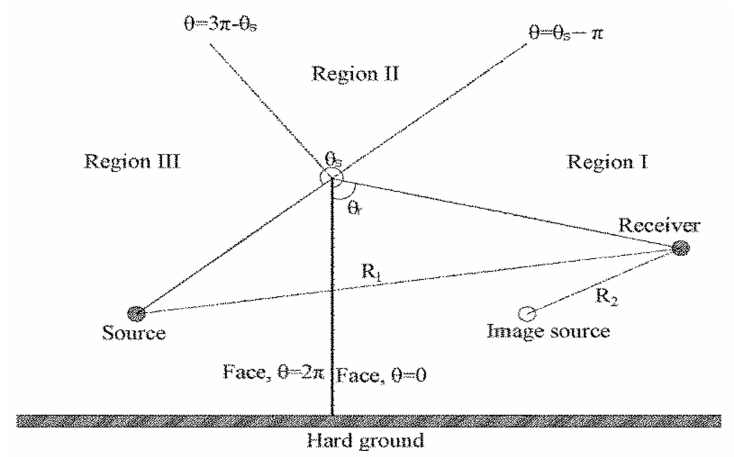
Figure 1. Schematic diagram of the di ff raction wave